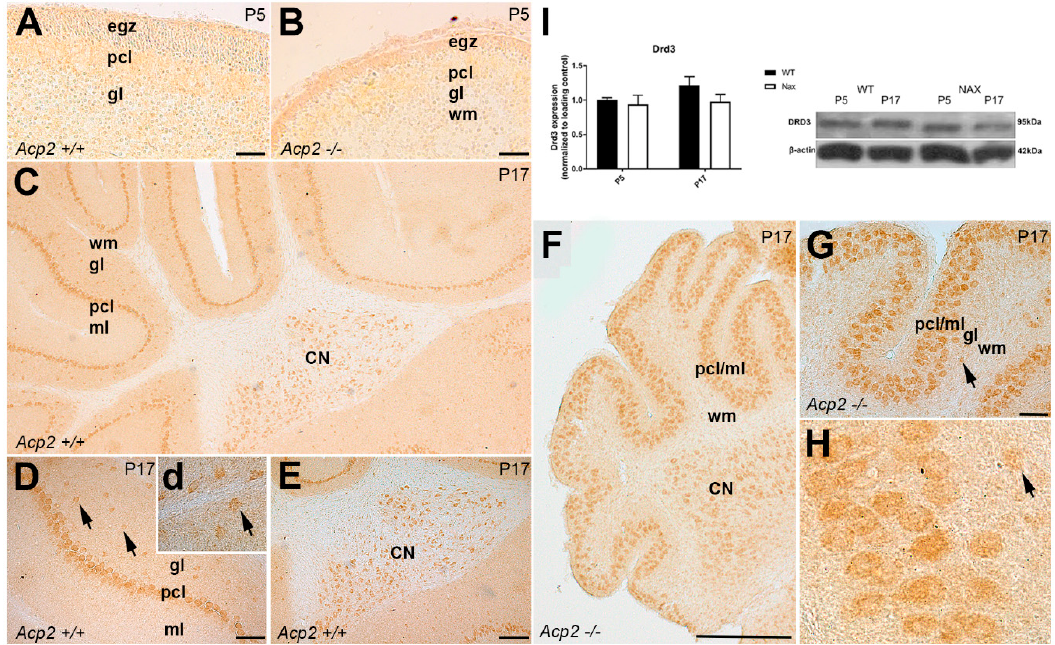
Figure 4. Frontal sections of wt and nax mouse cerebella: DRD3 expression at P5 and P17. ( A , B ) Immunoperoxidase staining for DRD3 in wt ( A ) and nax ( B ) cerebella at P5 shows weak immunoreactivity in the Pcl and external germinal zone (egz). ( C – E ) Immunoperoxidase staining for DRD3 in the wt cerebellum at P17 demonstrates immunoreactivity in the whole cortex of the wt cerebellum, mostly in PC somata ( C , D ) within scattered cell bodies in the gl (arrows indicated in D ( d )) and in cerebellar nuclei neurons (CNs) ( C , E ). ( F – H ) DRD3 immunostaining of a frontal section of the nax cerebellum at P17 shows strong immunoreactivity in PC somata in the Pcl / ml ( F – H ), CNs ( F ), and a few cells in the gl (arrows in G , H ). ( E ) Western blot analysis of whole cerebellar lysates revealed no significant di ff erences in DRD3 protein expression between wt and nax cerebella at P5 and P17 (wt: n = 3 and nax : n = 3). The data in the bar graph are presented as the mean of three